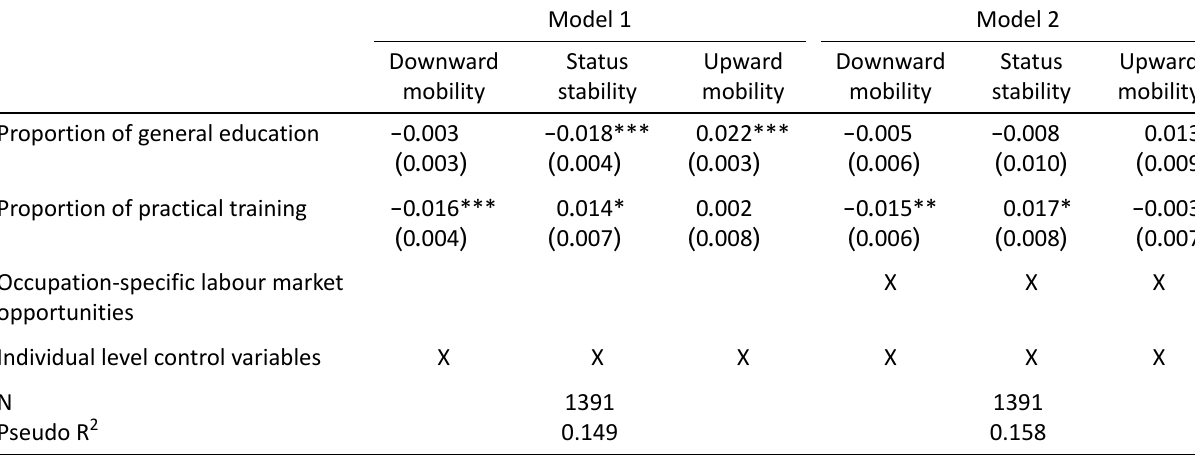
Table 3. Multivariate results for first